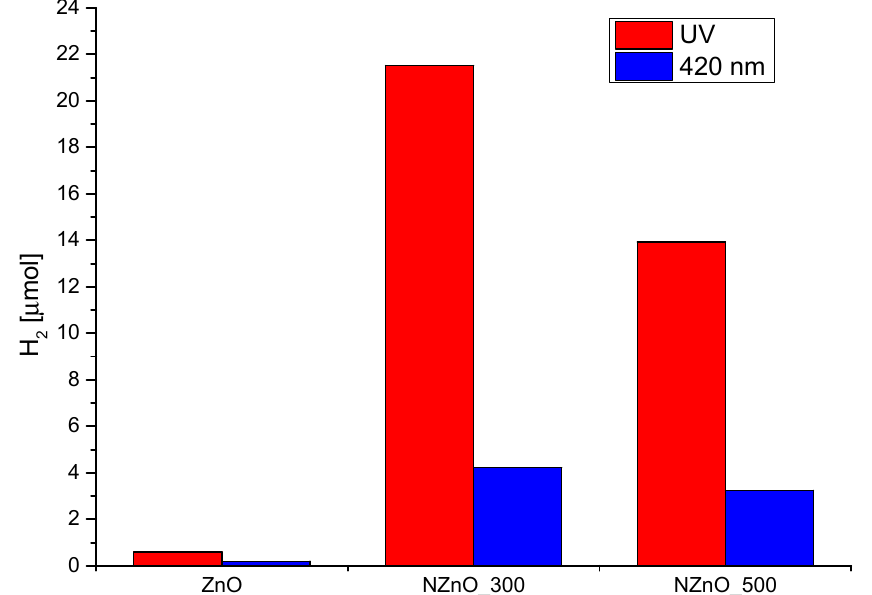
Figure 5. Comparison of H 2 production under both UV-Vis and visible light for the Zn-based